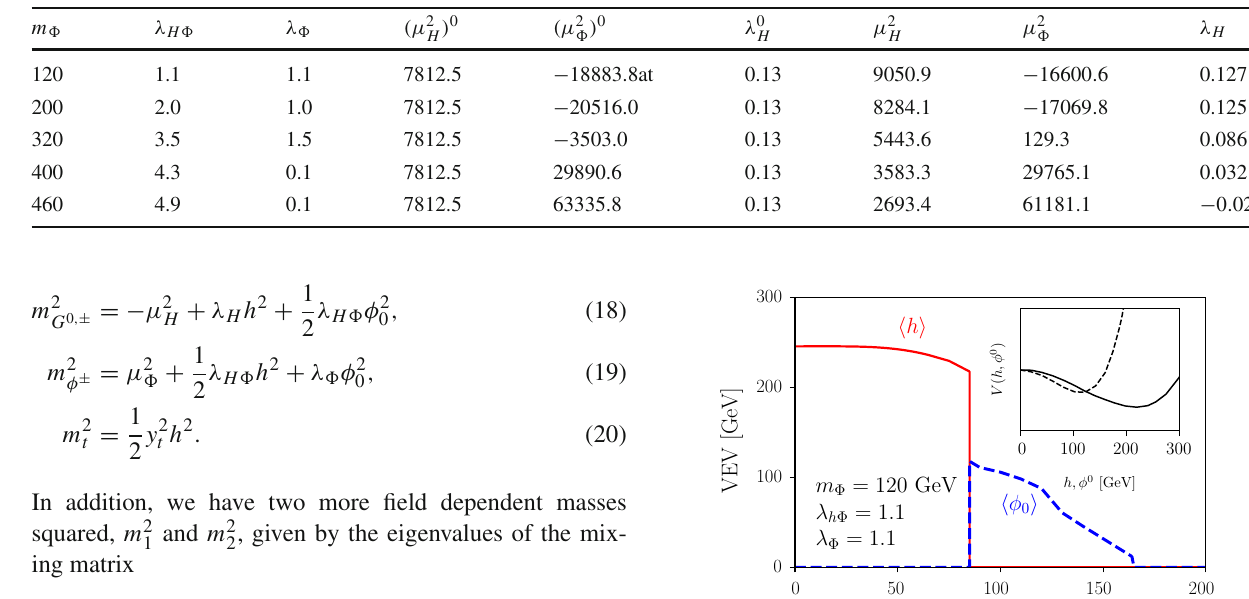
Table 1 Comparison of tree-level obtained parameters ( 0 ) versus the ones computed at one loop for different values of the three inputs